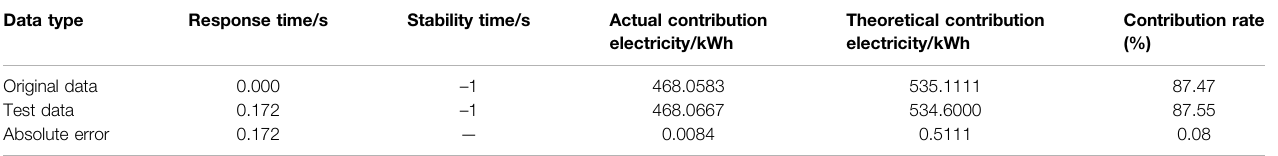
TABLE 6 | PFM assessment parameter table of the step signal simulation test. Data